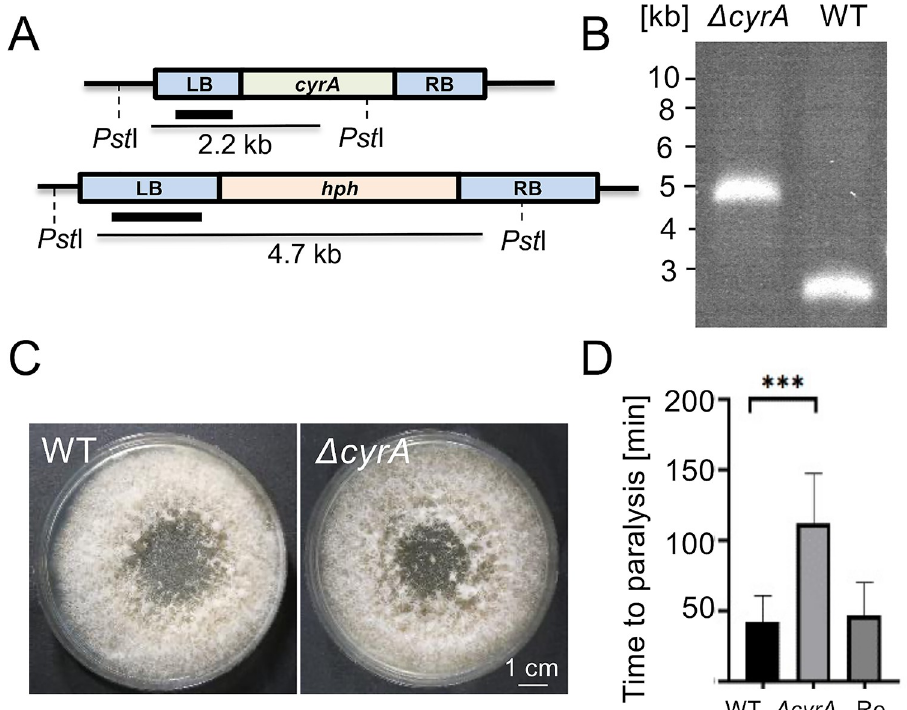
Fig 6. The cyrA gene is required for full virulence. (A) Scheme of the deletion strategy. The wild type cyrA -gene locus (upper panel) is replaced by the 1.8 kb hygromycin resistance cassette resulting in the Δ cyrA- mutant locus (lower panel). Southern-blot analysis using a 1 kb fragment from the LB as probe and the restriction enzyme Pst I for the digestion of the genomic DNA. (B) Confirmation of the Δ cyrA deletion using Southern-blot analysis. Genomic DNA was digested with Pst I, and the LB was used as probe. (C) The D . flagrans WT and the Δ cyrA- deletion strain (sNH11) were grown for seven days at 28˚C on PDA. (D) Virulence assay with wild type (WT), the Δ cyrA- mutant strain and the strain re-complemented with the cyrA ORF (sNH27) under its native promoter (Rec.). Multiple traps were observed and the time from the capturing event to full paralysis was taken. Error bars indicate the standard deviation. A student’s t-test was performed for statistical analysis ( ��� = p-value < 0.0001; n [WT] = 29 n [KO] = 26 n [Rec] =